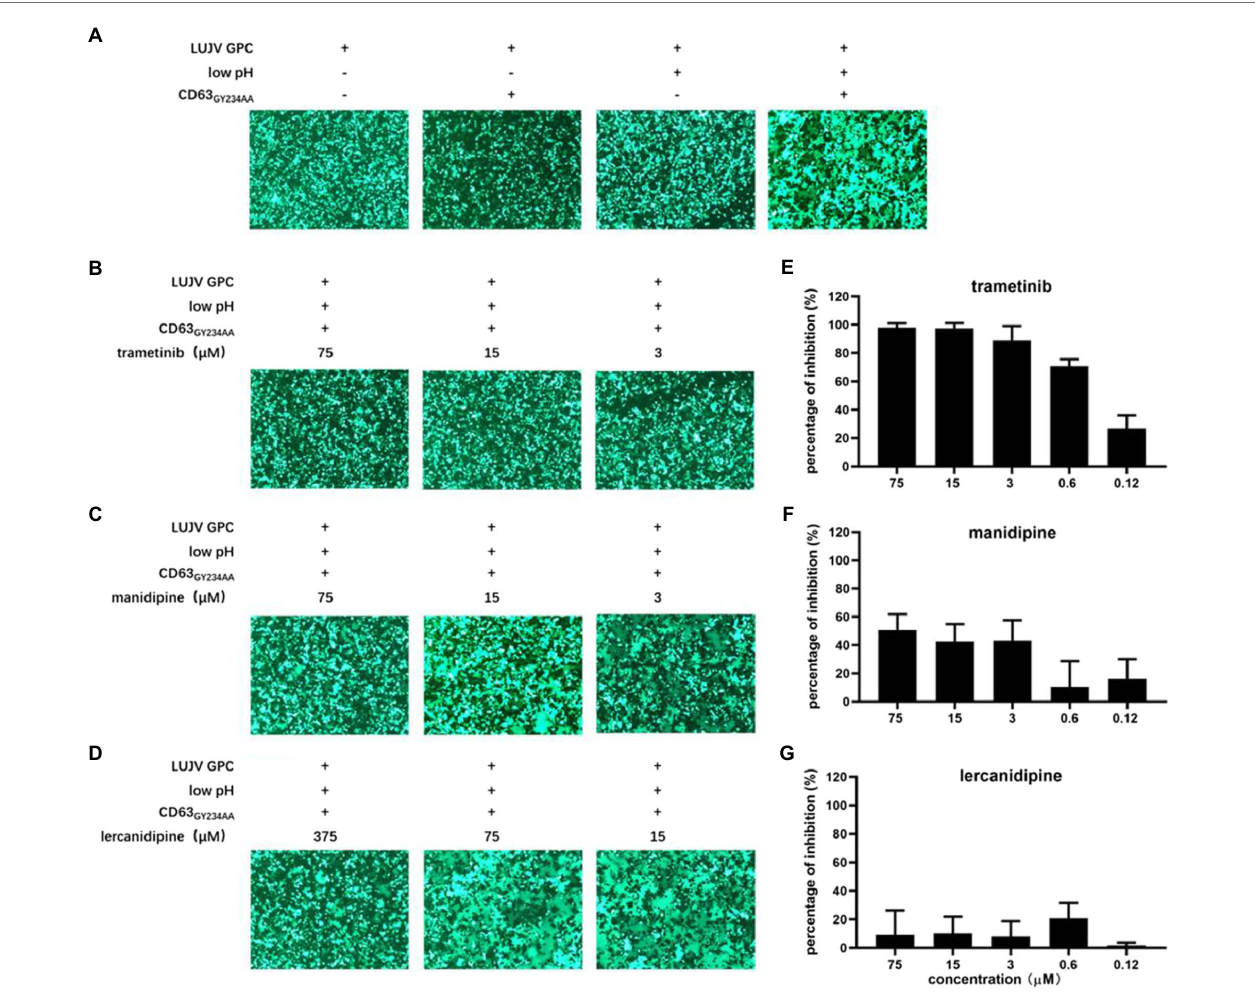
FIGURE 2 | Inhibition of LUJV glycoprotein (GPC)-mediated membrane fusion with trametinib. (A) LUJV GPC-mediated membrane fusion was triggered by the low pH in the presence of membrane-anchored CD63. 293 T cells co-transfected with pCAGGS-LUJV GPC, pcDNA 3.1-CD63 GY234AA , and pEGFP-N1 were treated with acidified (pH 5.0) medium for 20 min. The cells were then washed and incubated with neutral medium, and syncytium formation was imaged 1 h later. (B–D) Qualitative evaluations of the effects of trametinib (B) , manidipine (C) , and lercanidipine (D) on LUJV GPC-mediated membrane fusion. Images are representative fields from three independent experiments. (E–G) Quantitative analysis of the effects of trametinib (E) , manidipine (F) , and lercanidipine (G) on LUJV GPC-mediated membrane fusion using ImageJ. Data are presented as means ± SD from three or four independent